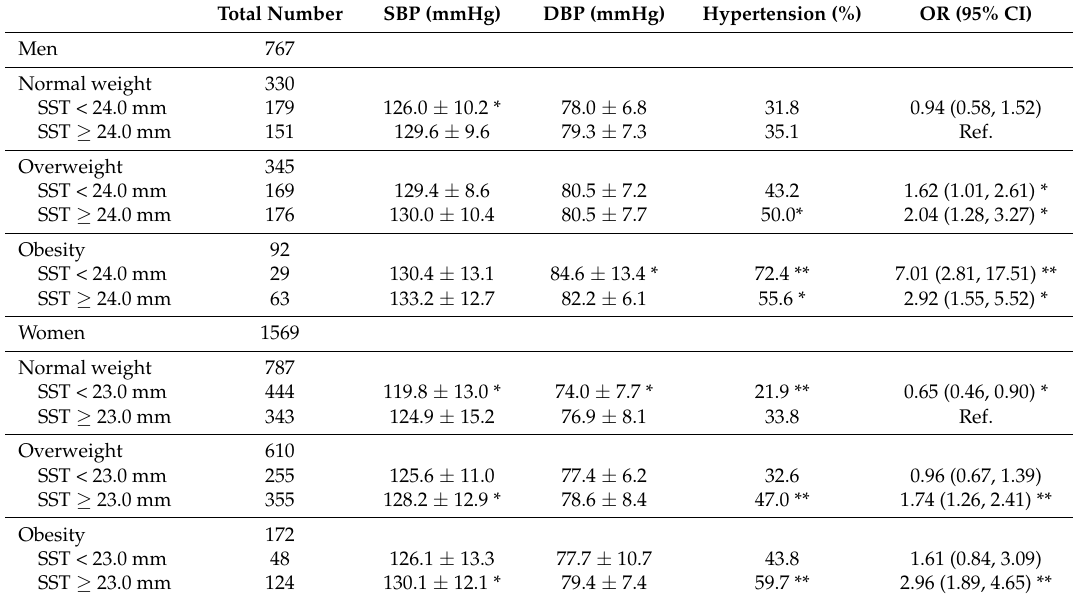
Table 4. Blood pressure and hypertension in different body mass index and subscapular